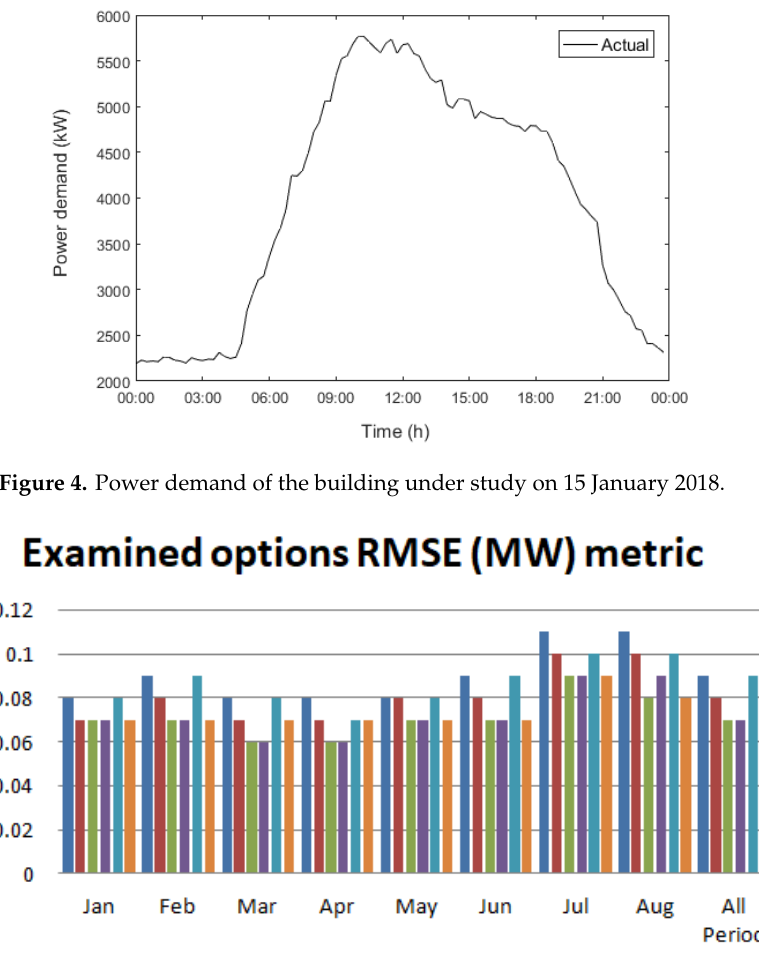
Table 10. Evolution of the average error in percentage for each option. Epochs